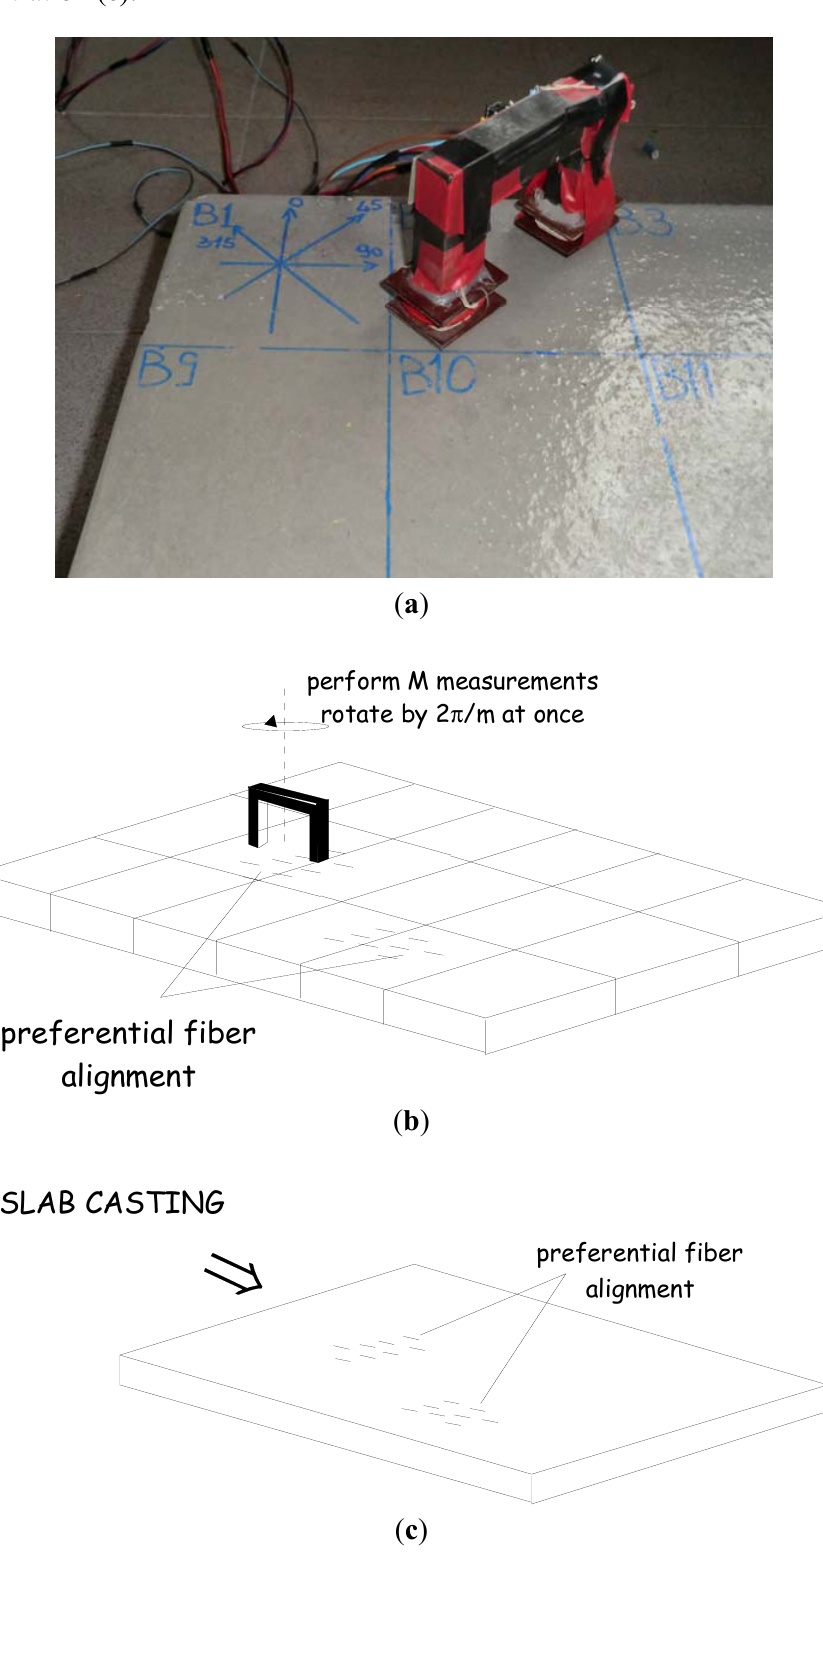
Figure 6. Magnetic measuring sensor for ND characterization of fiber dispersion and orientation in FRC slabs ( a ); schematic of the measuring procedure ( b ); casting of a FRC slab specimen featuring preferential fiber alignment ( c ); ND estimated fiber dispersion cartography ( d ) and comparison between ND estimated and destructively assessed local fiber concentration ( e